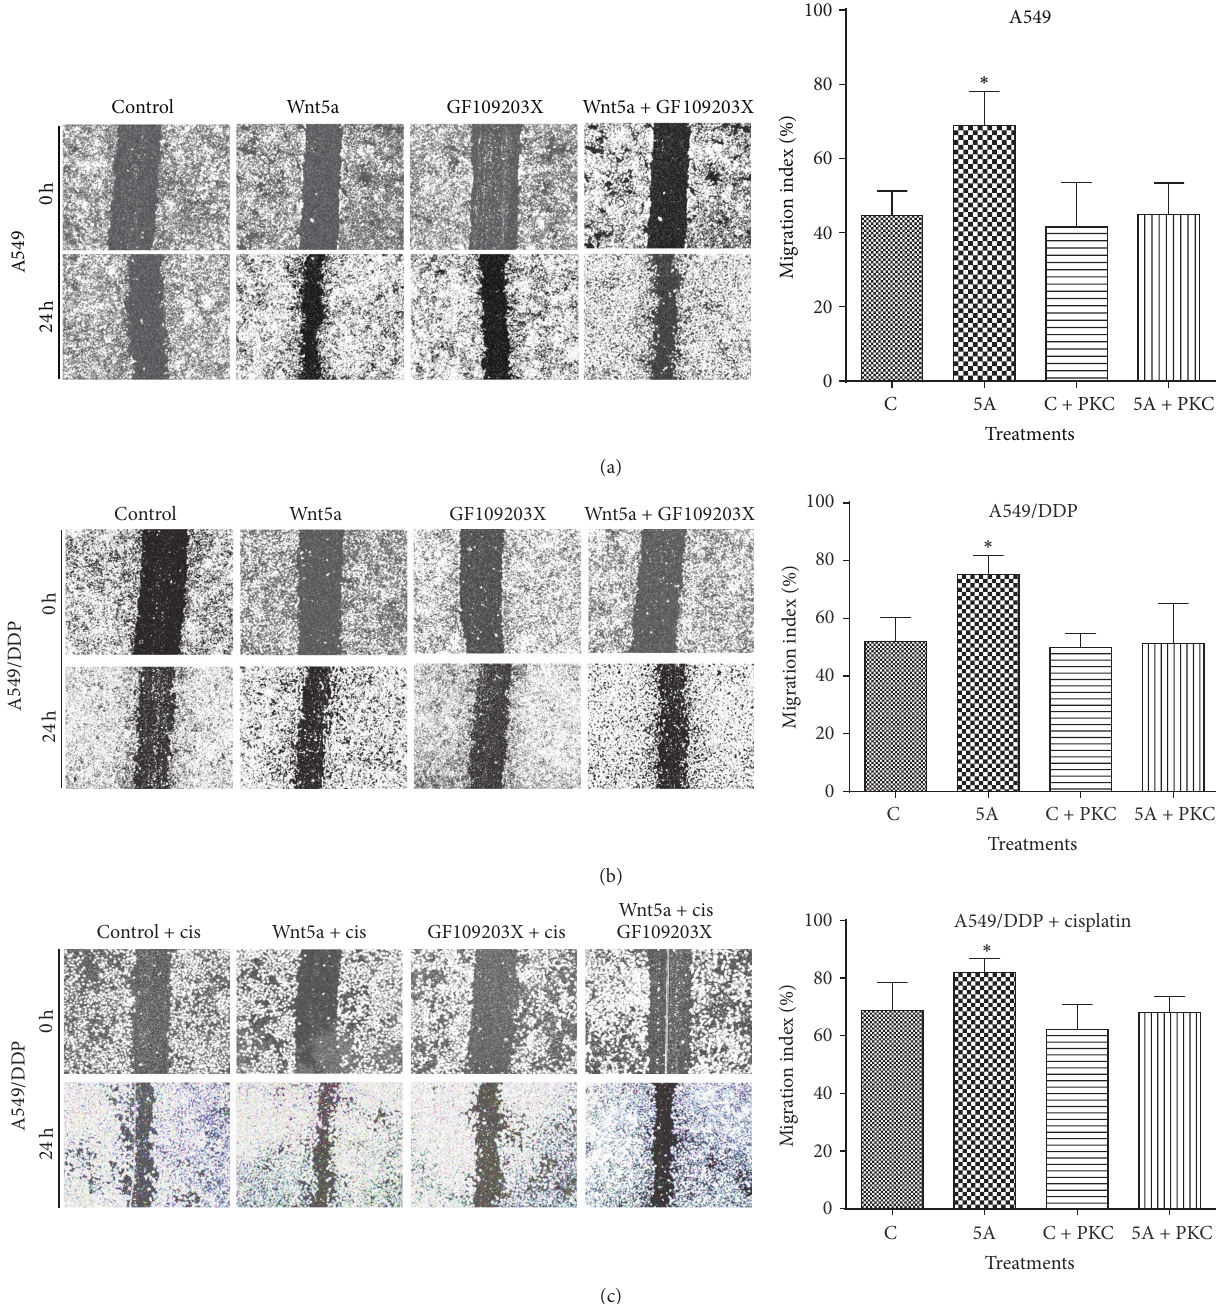
Figure 2: Wnt5a promotes cell migration in lung cancer cells in vitro . A549 and A549/DDP cells were cultured in Wnt5a-CM with or without PKC inhibitor GF109203X. The capability of cell migration was accessed in terms of a scratch assay. (a) Representative images of scratch assays for A549 cells (left panel) and its relevant quantification of the results of cell migration index (right panel). (b) Representative images of scratch assays for A549/DDP cells (left panel) and its relevant quantification of the results of cell migration index (right panel). (c) Representative imagesofscratchassaysforA549/DDPcellsinthepresenceofcisplatin(leftpanel)anditsrelevantquantificationoftheresultsofcellmigration index (right panel). Wnt5a showed an ability to enhance cell migration in both A549 cells and A549/DDP cells. In contrast, GF109203X was able to inhibit the Wnt5a-promoted migration in these cells. Compared with Control-CM group, ∗ represents 𝑝 < 0.05 . Data represented the mean ± SD from three independent triplicated experiments ( 𝑁 = 9 ). GF: